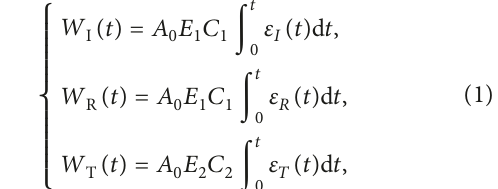
max with the joint angle of the filled